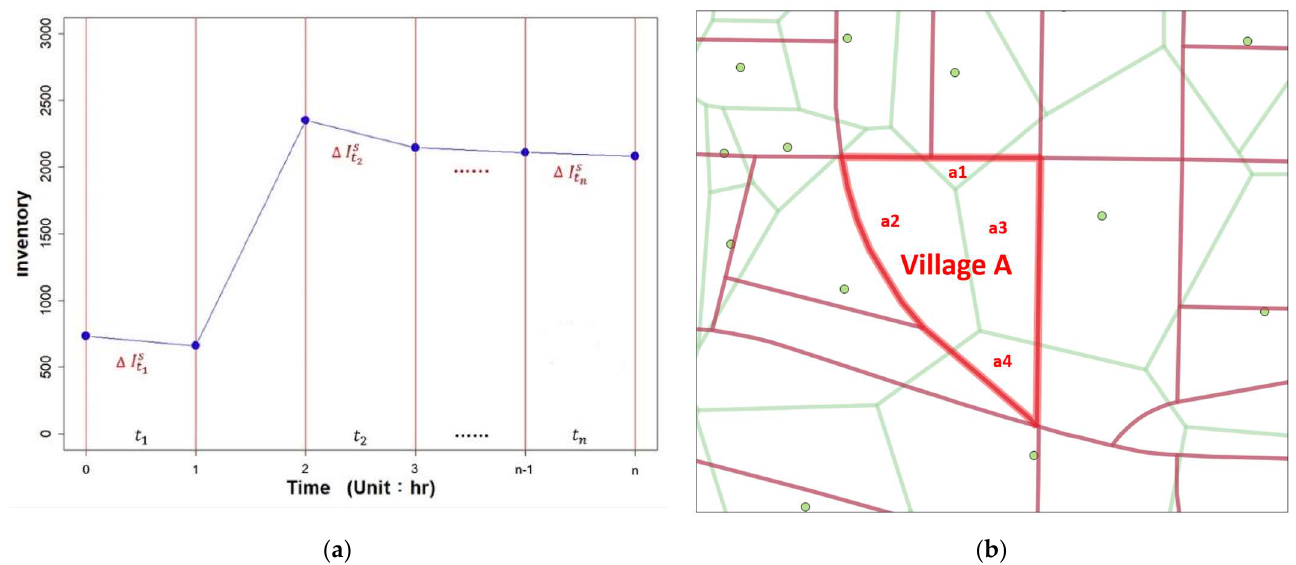
Figure 1. ( a ) Preprocessing the inventory datasets of adult surgical masks in a pharmacy; ( b ) areal interpolation of the supply from Voronoi diagrams (source zone, colored in green) to villages (target zone, colored in red). (For example, village A = a1 + a2 + a3 + a4).